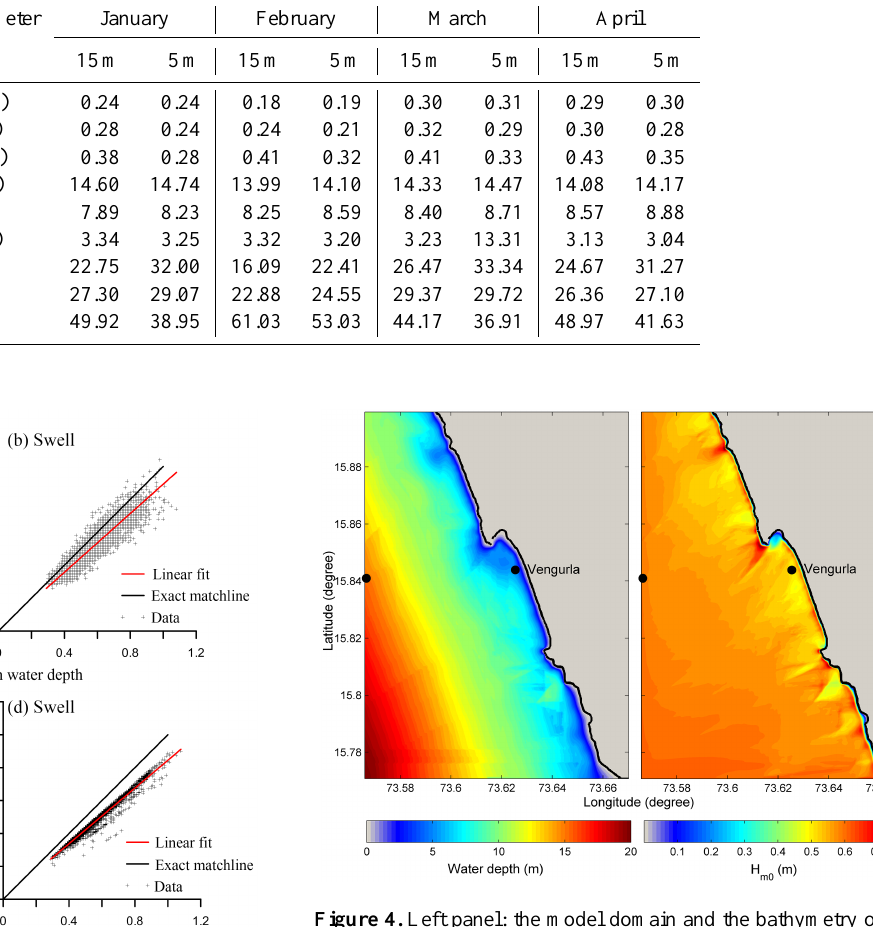
Figure 4. Left panel: the model domain and the bathymetry of the study area. Right panel: the spatial variation in average significant wave height in April 2015. The wave measurement locations are shown in dark